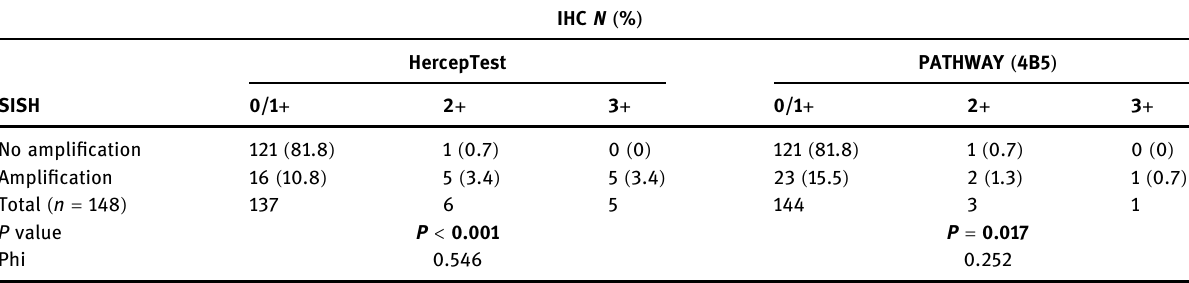
Table 4: Correlation of SISH and IHC